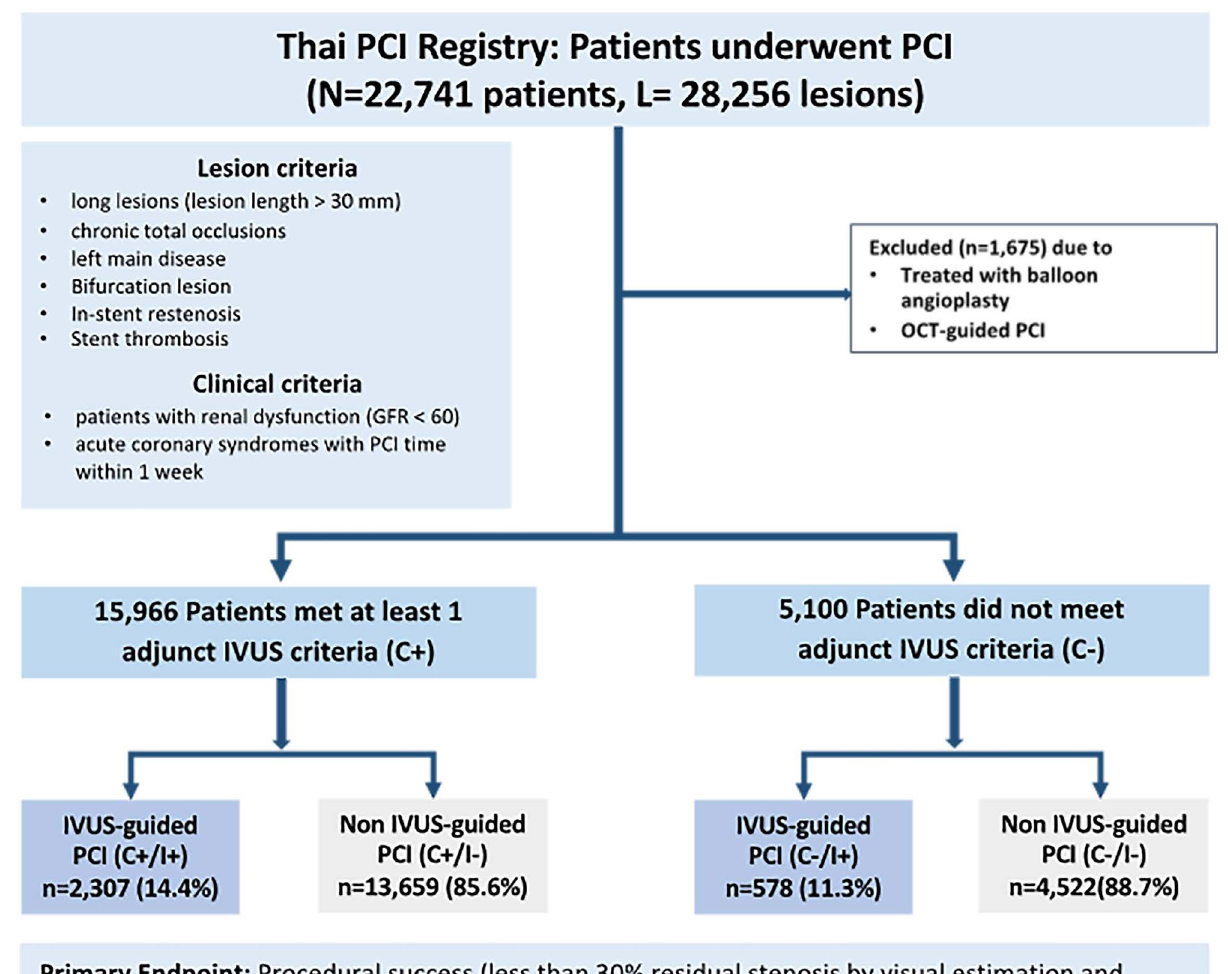
Figure 1. Patient flow chart. Abbreviations: C + , met criteria; C−, unmet criteria; GFR, glomerular filtration rate; I + , IVUS-guided PCI, I−, angio-guided PCI; IVUS, intravascular ultrasound; MI, myocardial infarction; OCT, optical coherence tomography; PCI, percutaneous coronary